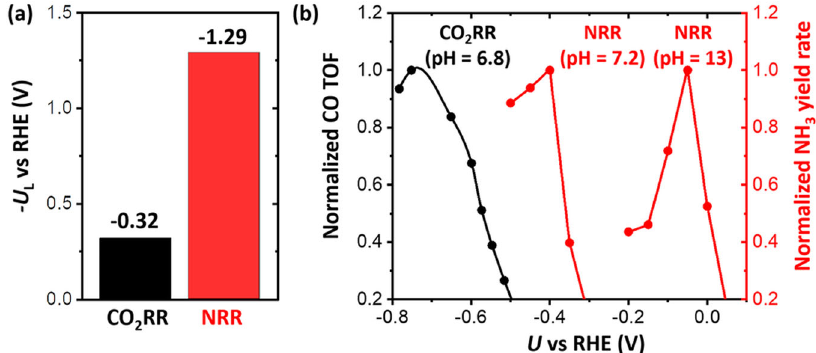
Fig. 1 Comparison of onset potential for CO 2 RR and that for NRR on Fe@N 4 catalysts. a U L for CO 2 RR (black, CO formation) and NRR (red, NH 3 formation) obtained on the Fe single-atom-embedded N-doped graphene using DFT calculations with the CHE model. b Potential-dependent measurements of turnover frequency (TOF) of CO in CO 2 RR (black) and NH 3 yield rate in NRR (red) taken from the literature; CO TOF (pH = 6.8) is taken from Ju et al. 24 and NH 3 yield rates at pH = 7.2 and 13 are taken from Lü et al. 23 and Zhang et al. 13 , respectively. Normalized CO TOF and NH 3 yield rates are obtained by dividing their absolute values with